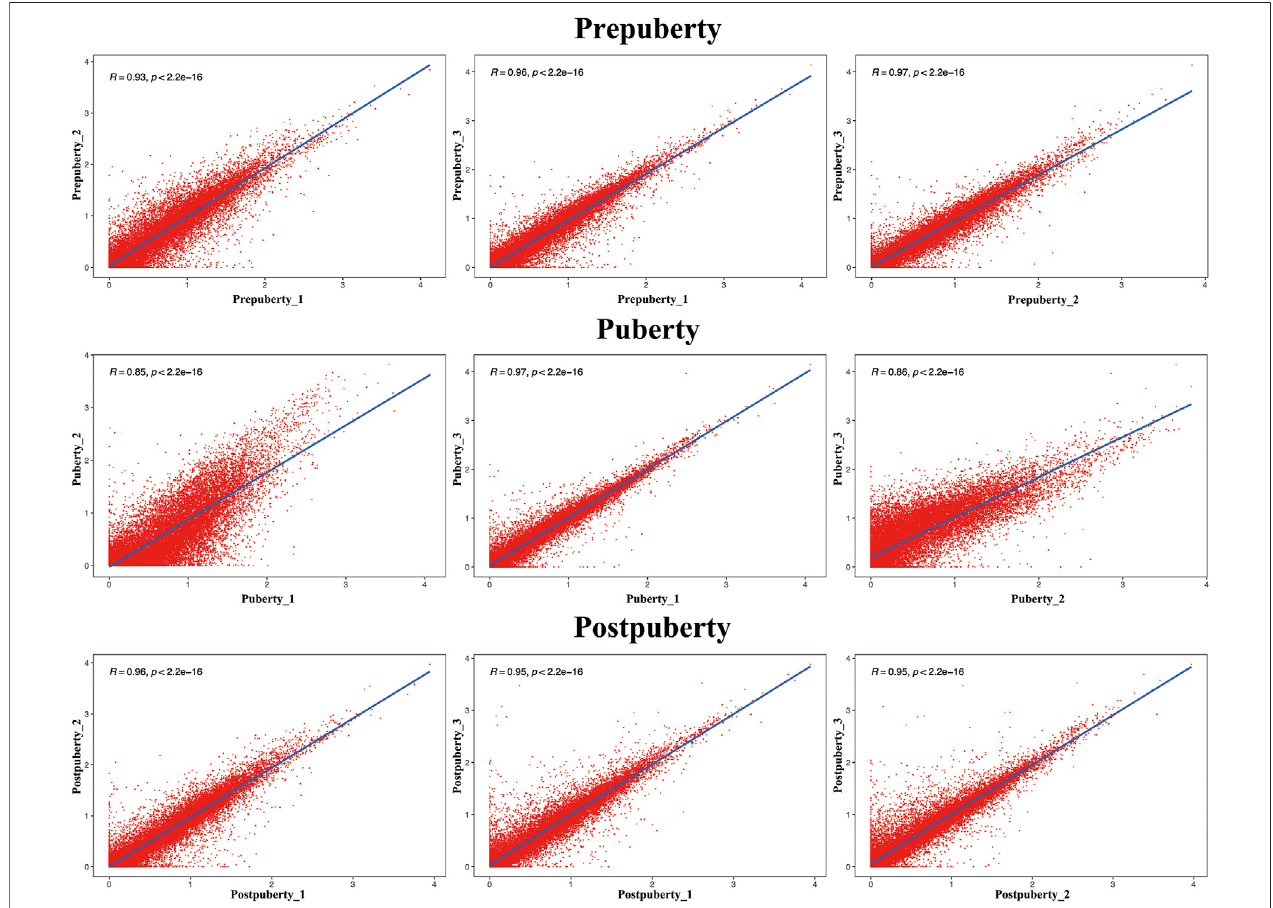
FIGURE 3 | Assessment of correlations among the three groups by analysis of replicate